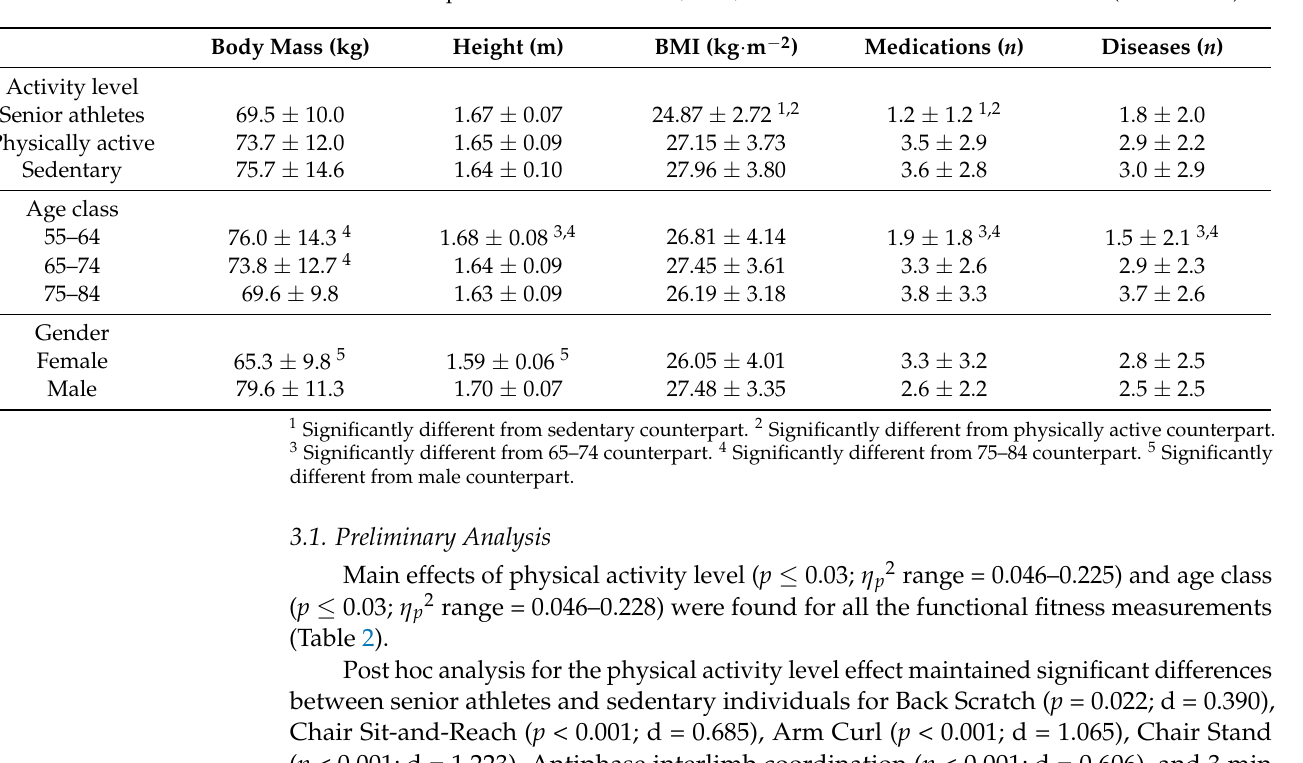
Table 1. Anthropometric characteristics, BMI, number of medications and diseases (mean ±